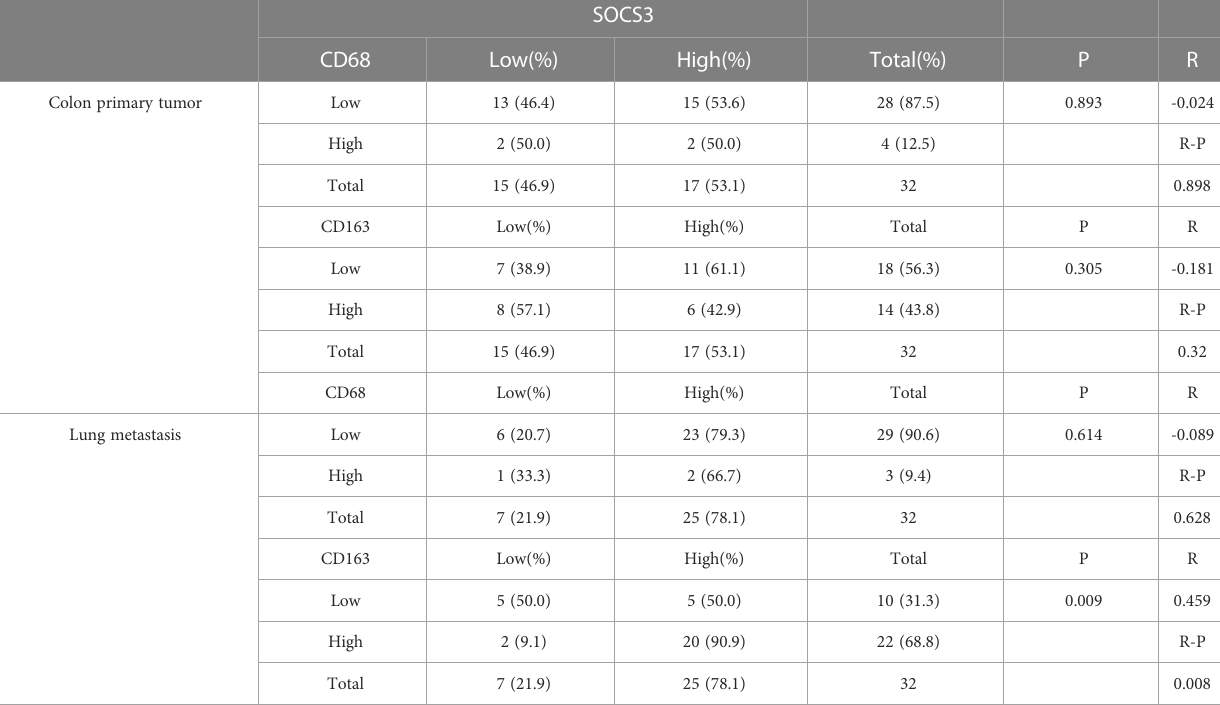
TABLE 4 Correlation between SOCS3 expression and macrophage markers in colon primary tumor and lung